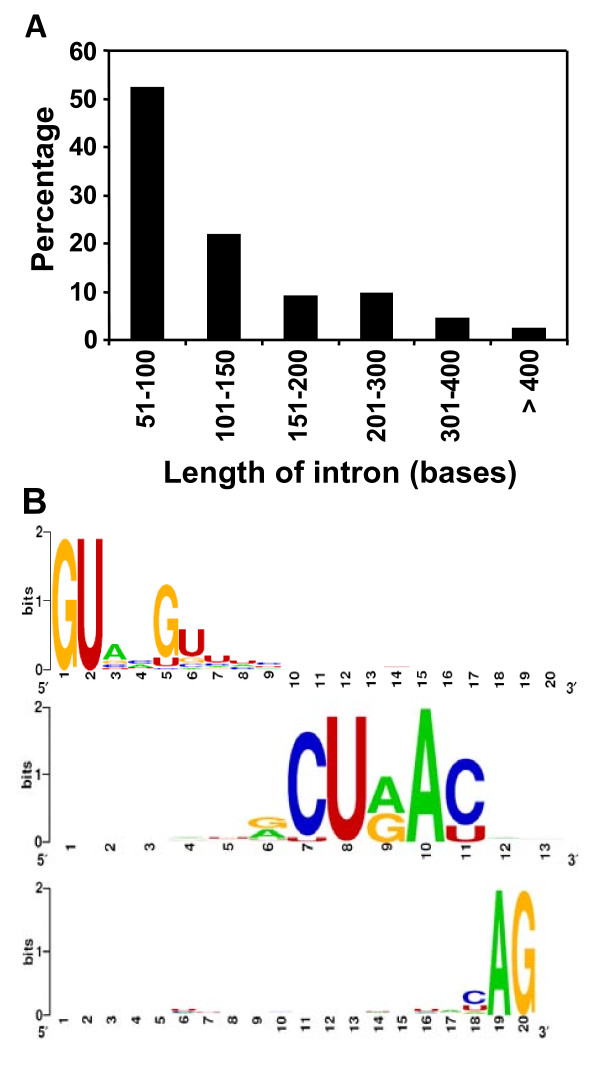
Intron length distribution and splicing site context. (A) Intron length distribution of 68 full-length cDNA sequences. (B) Splicing site consensus sequences for 5' exon-intron junctions (upper), branch point (middle), and 3' intron-exon junctions (lower) were calculated using WebLogo server at http://weblogo.berkely.edu. The general consensus sequences of each region were displayed in order of predominance from top to bottom at each position with large letter being higher frequency.